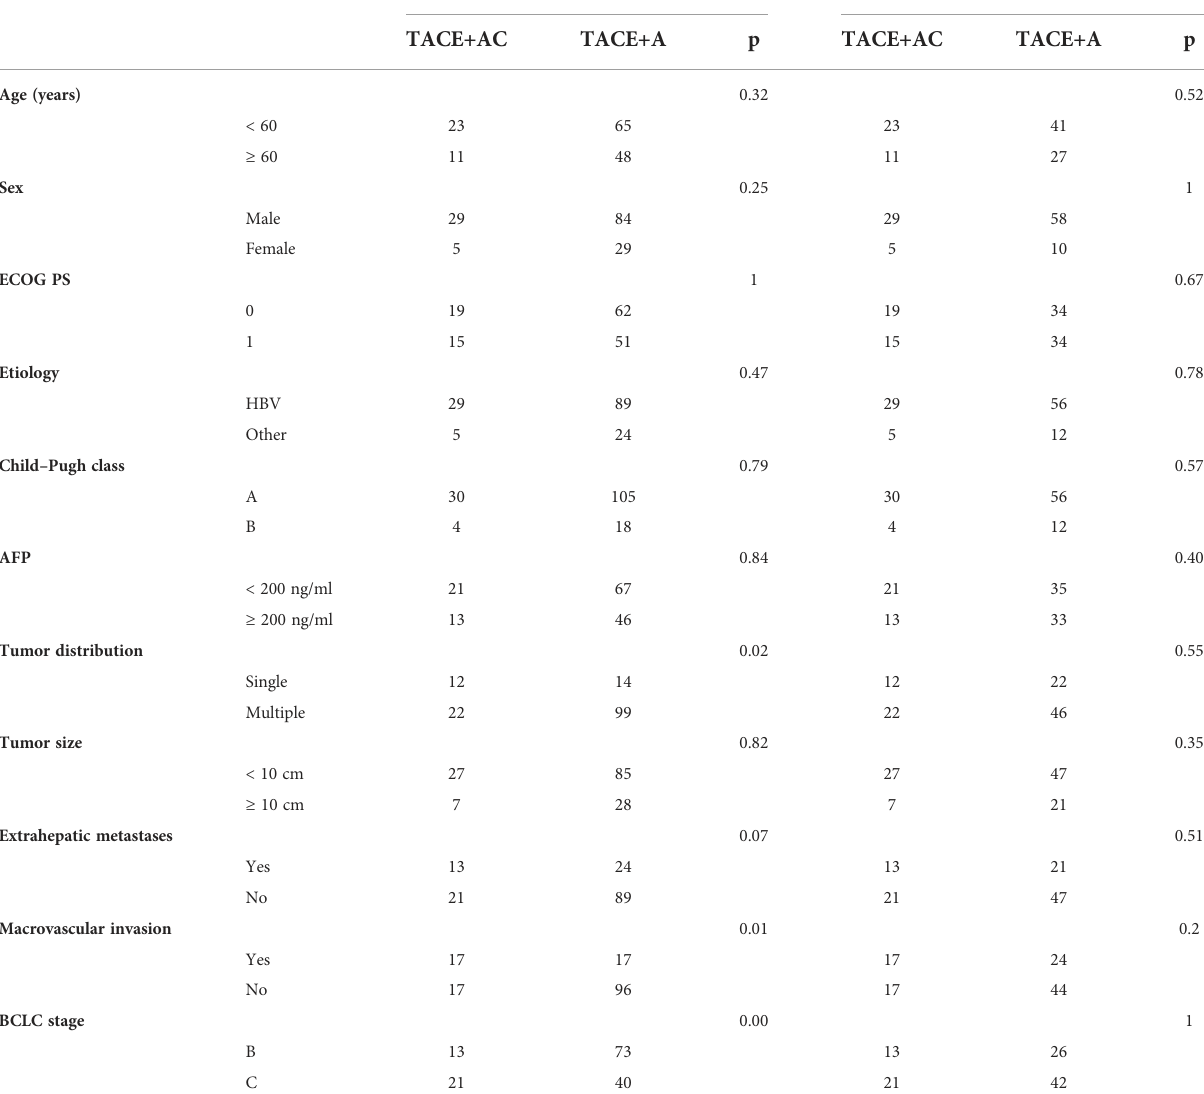
Before PSM After